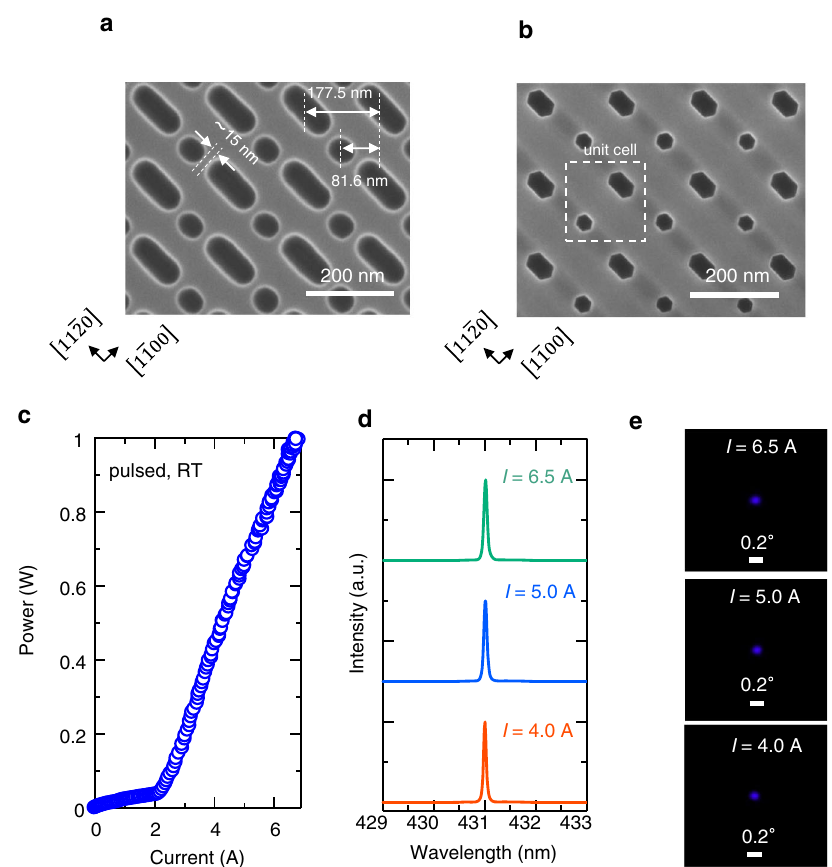
Fig. 5 SEM image of double-lattice photonic-crystals and lasing characteristics of a GaN-based PCSEL with double-lattice photonic crystals under pulsed operation. a SEM image of double-lattice holes fabricated by dry etching. b SEM image of double-lattice photonic crystals after the regrown GaN layer is removed by FIB. c Output power as a function of current under pulsed operation at room temperature. d Emission spectra at injection currents of 4.0A, 5.0A and 6.5A. The resolution of the spectrometer used for the measurements was 0.05nm. e Measured far- fi eld patterns at injection currents of 4.0A, 5.0A and